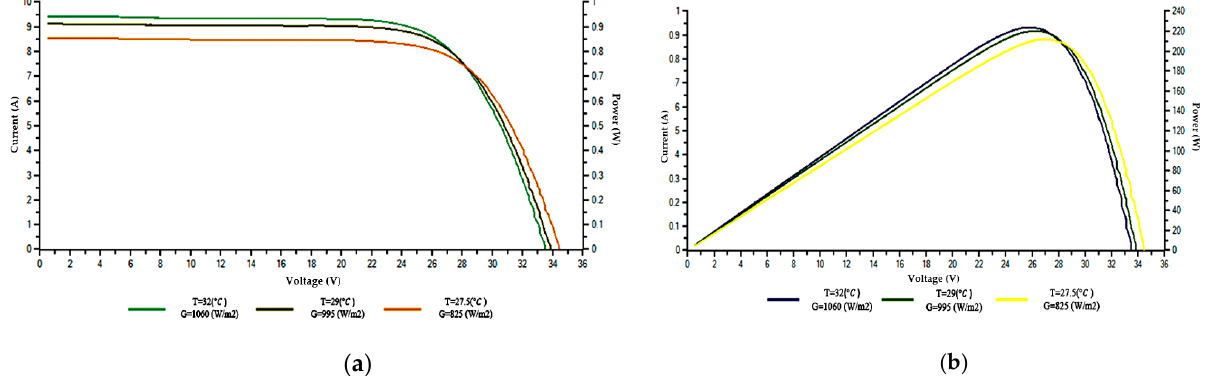
Figure 7. Power-voltage and current-voltage characteristics for 35°, 260 W panel. ( a ) Voltage-Current diagram, ( b ) Power- Voltage diagram.